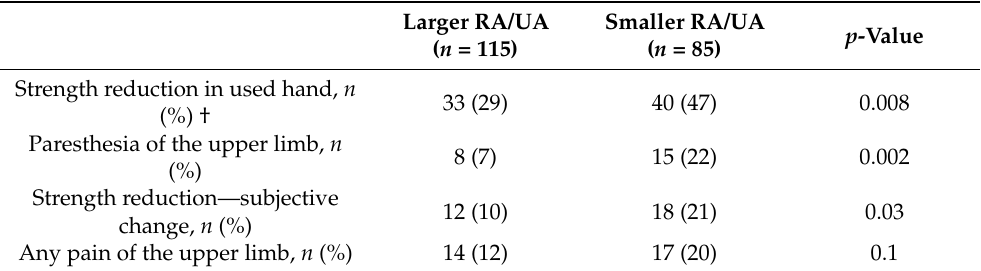
Table 2. Primary and secondary endpoints after coronary angiography/percutaneous coronary intervention (CAG/PCI) at 30-day follow-up. Larger RA/UA Smaller RA/UA p -Value ( n = 115) ( n = 85) Strength reduction in used hand, n 33 (29) 40 (47) 0.008 (%) † Paresthesia of the upper limb, n 8 (7) 15 (22) 0.002 (%) Strength reduction—subjective 12 (10) 18 (21) 0.03 change, n (%) Any pain of the upper limb, n (%) 14 (12) 17 (20) 0.1